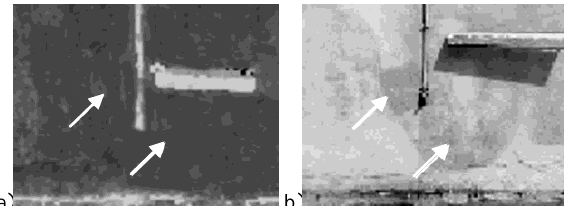
Figure 13. Moisture visible on a fragment of the building's